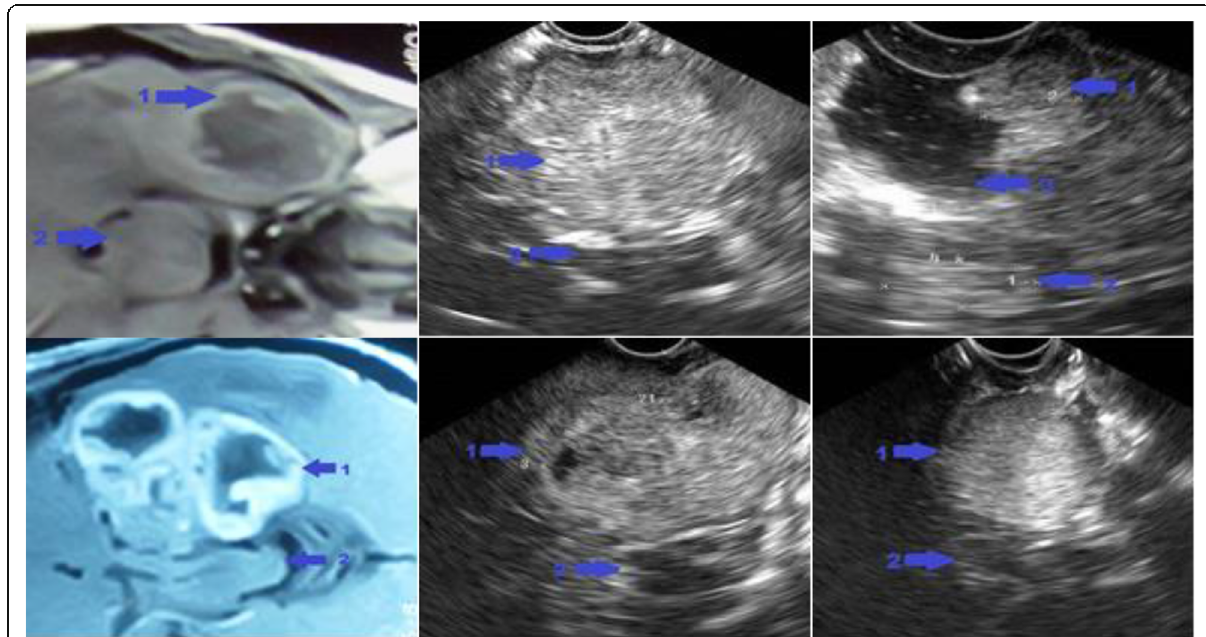
Fig. 4 Brain stem; arrow1 brain mass lesion, arrow2 brain stem (heterogeneous hypo-echogenic or hyper-echogenic), and arrow3 resection cavity